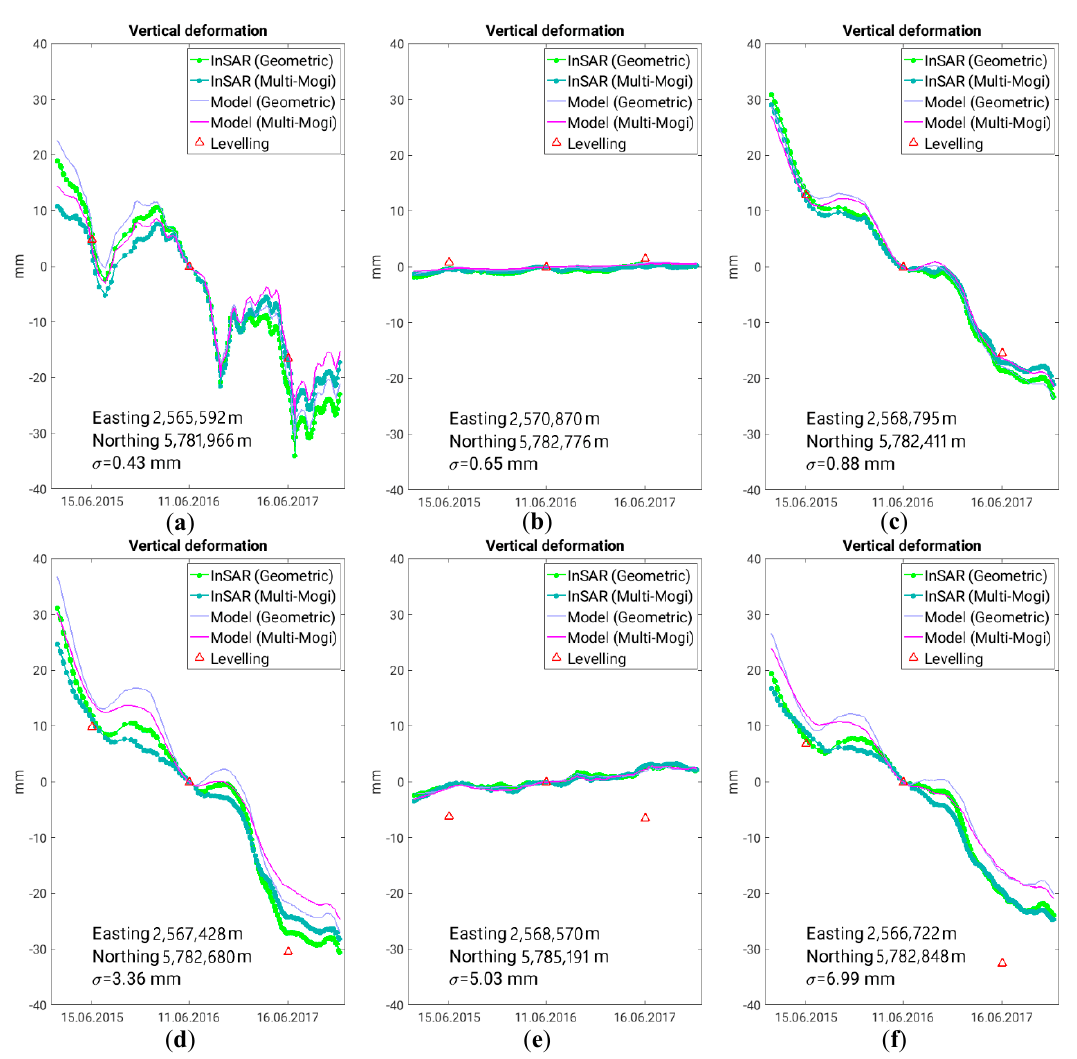
Figure 11. Examples of vertical displacement time series for selected points.